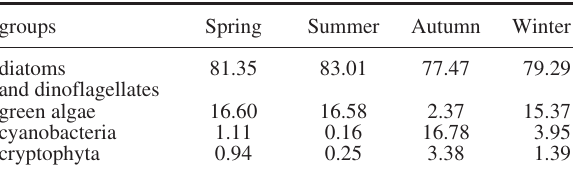
Table 2. – Seasonal variation of phytoplankton composition (%) in Sanya Bay. groups